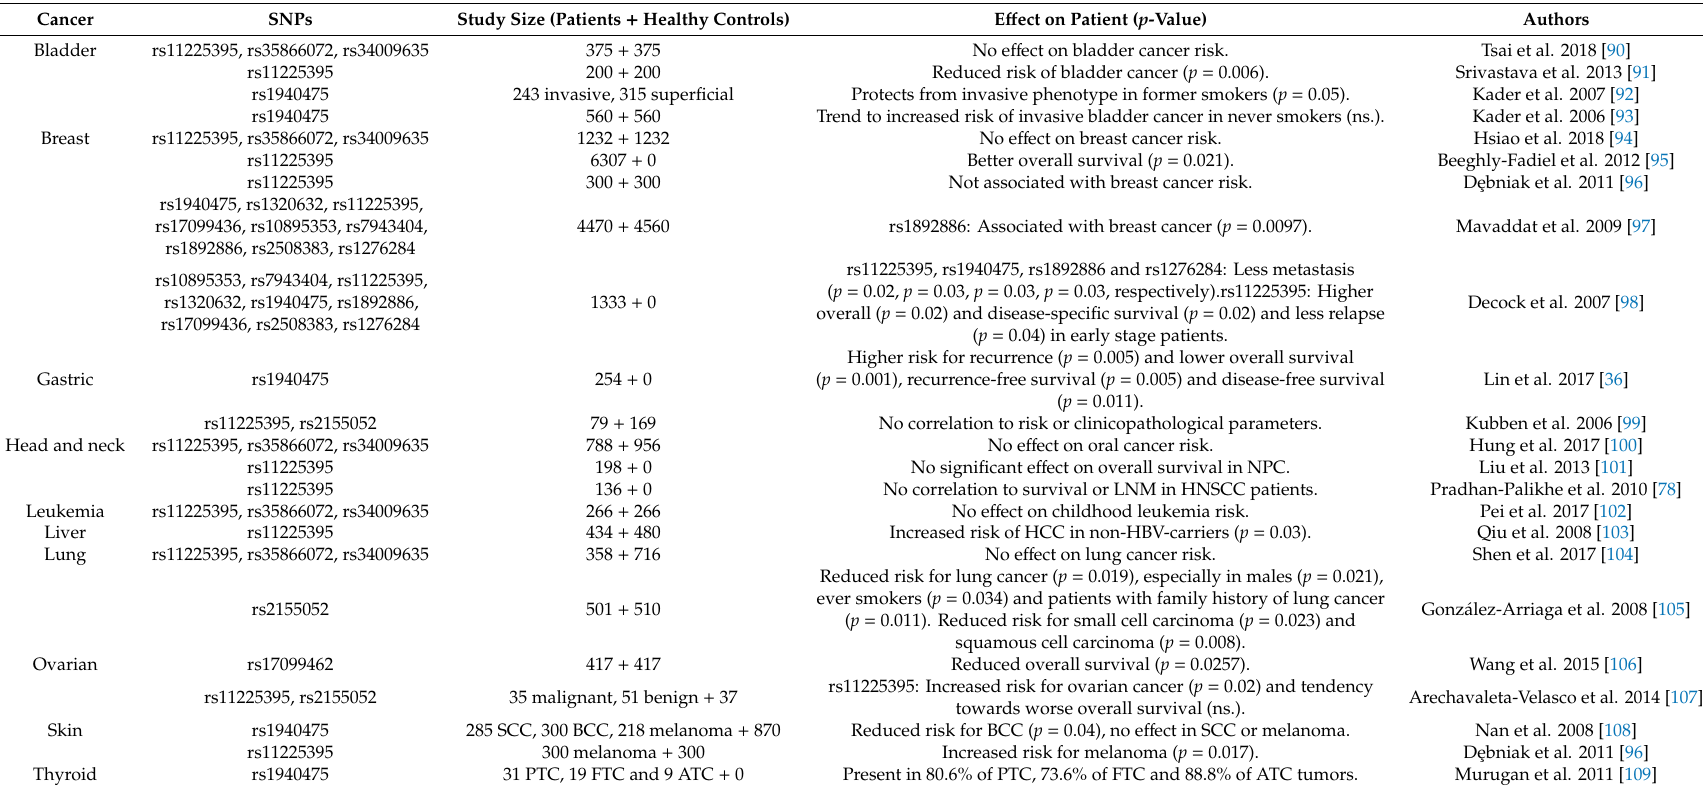
Table 3. Matrix metalloproteinase 8 SNPs and